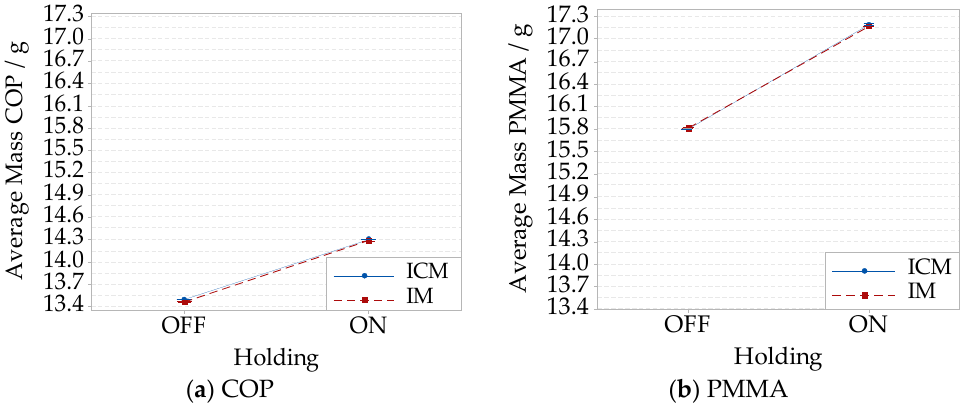
Figure 13 . Interaction plots showing the average part mass obtained for IM without the holding pressure, IM and ICM without the holding pressure, and ICM for: ( a ) COP material; ( b ) PMMA material.